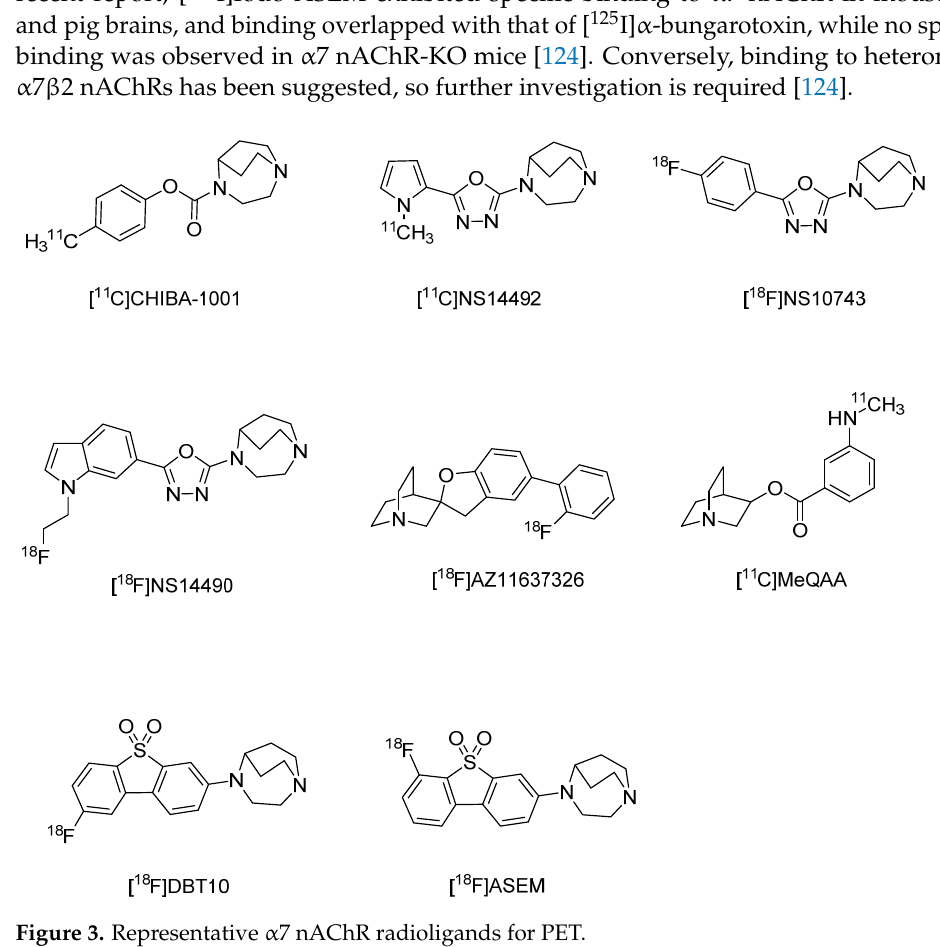
Figure 4. Representative α 7 nAChR radioligands for SPECT. 4. Microglia and AD Pathophysiology Microglia are the resident macrophages within the CNS, and so play key roles in the brain immune response, as well as in brain development and homeostasis [22]. Microglia express pattern recognition receptors (PRRs) that detect damage-associated molecular patterns (DAMPs), pathogen-associated molecular patterns (PAMPs), and neurodegener- ation-associated molecular patterns (NAMPs), indicating tissue damage, entry of patho- genic microorganisms, and various neurodegenerative events in the CNS, respectively [36,125,126]. Upon recognition of these signals, microglia are transformed into a reactive phenotype that initiates and modulates the neuroinflammatory response. This neuroin- flammatory response involves the release of pro-inflammatory cytokines, chemokines,